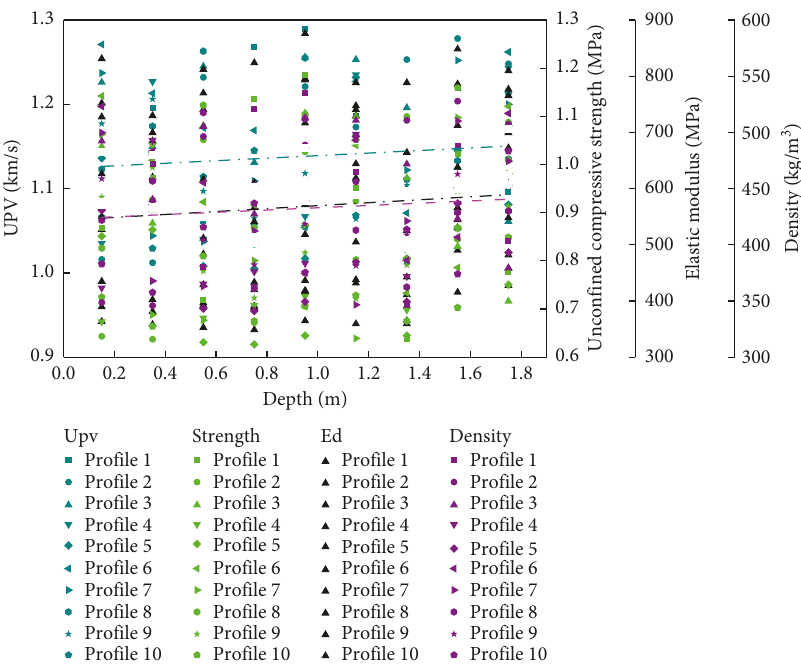
Figure 28: On-site test result. Dashed lines indicate linear fitting of UPV, strength E